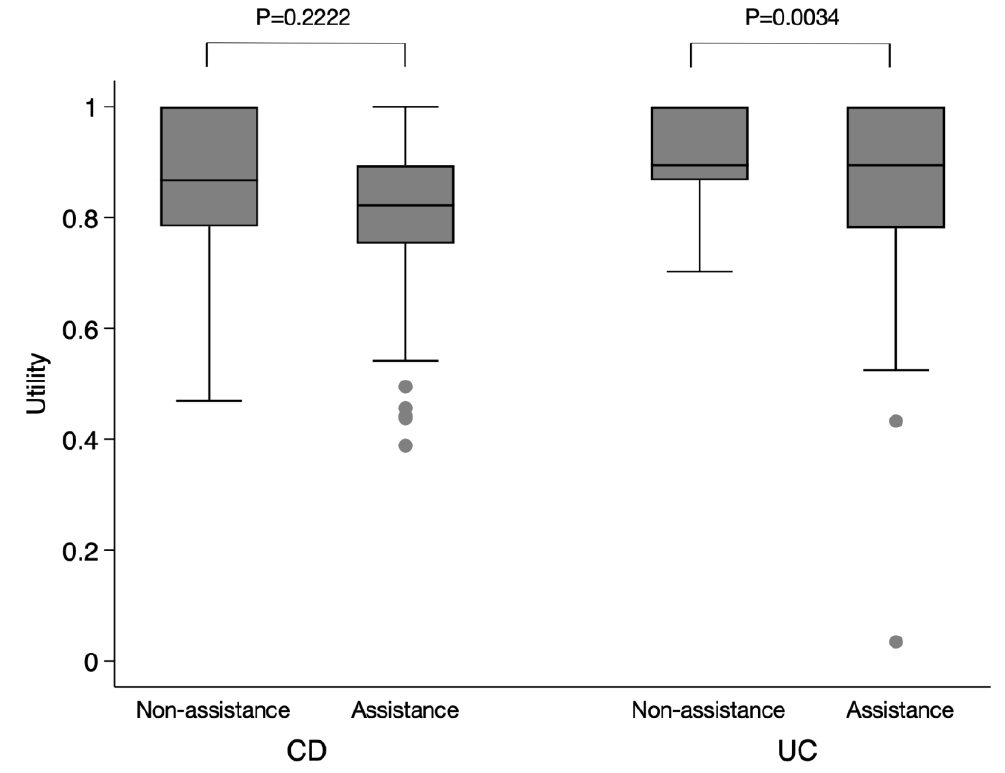
Figure 1. BoxplotsofEQ-5D-5Lutilityweight. (EQ-5D-5L:five-dimension, Figure 1. Box plots of EQ-5D-5L utility weight. (EQ-5D-5L: five-dimension, five-level EuroQol instrument).